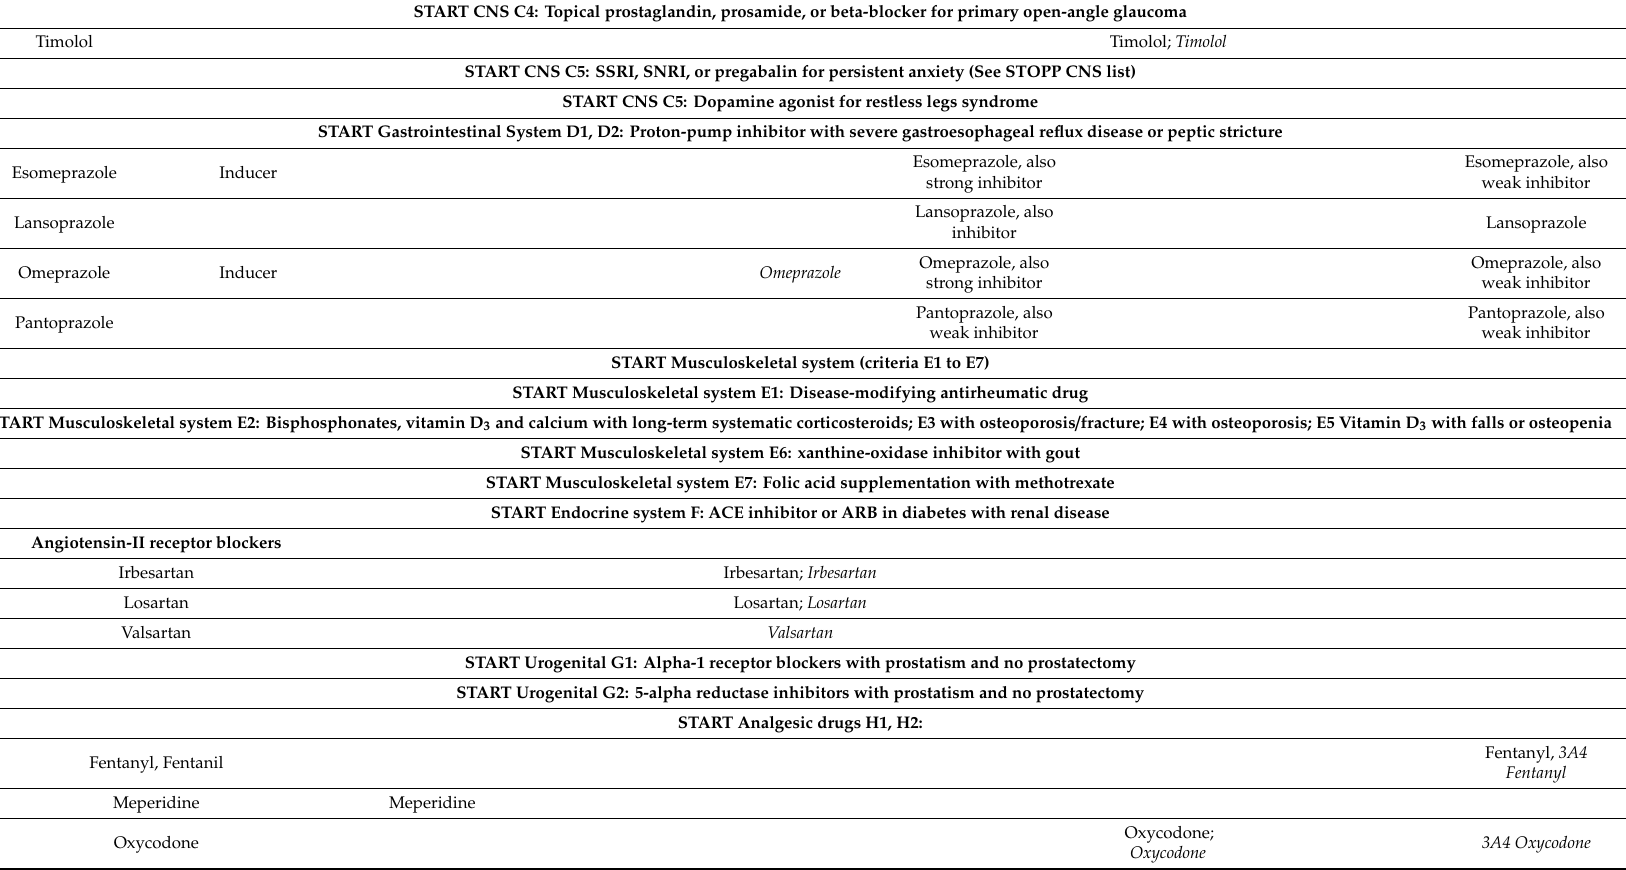
START CNS C4: Topical prostaglandin, prosamide, or beta-blocker for primary open-angle